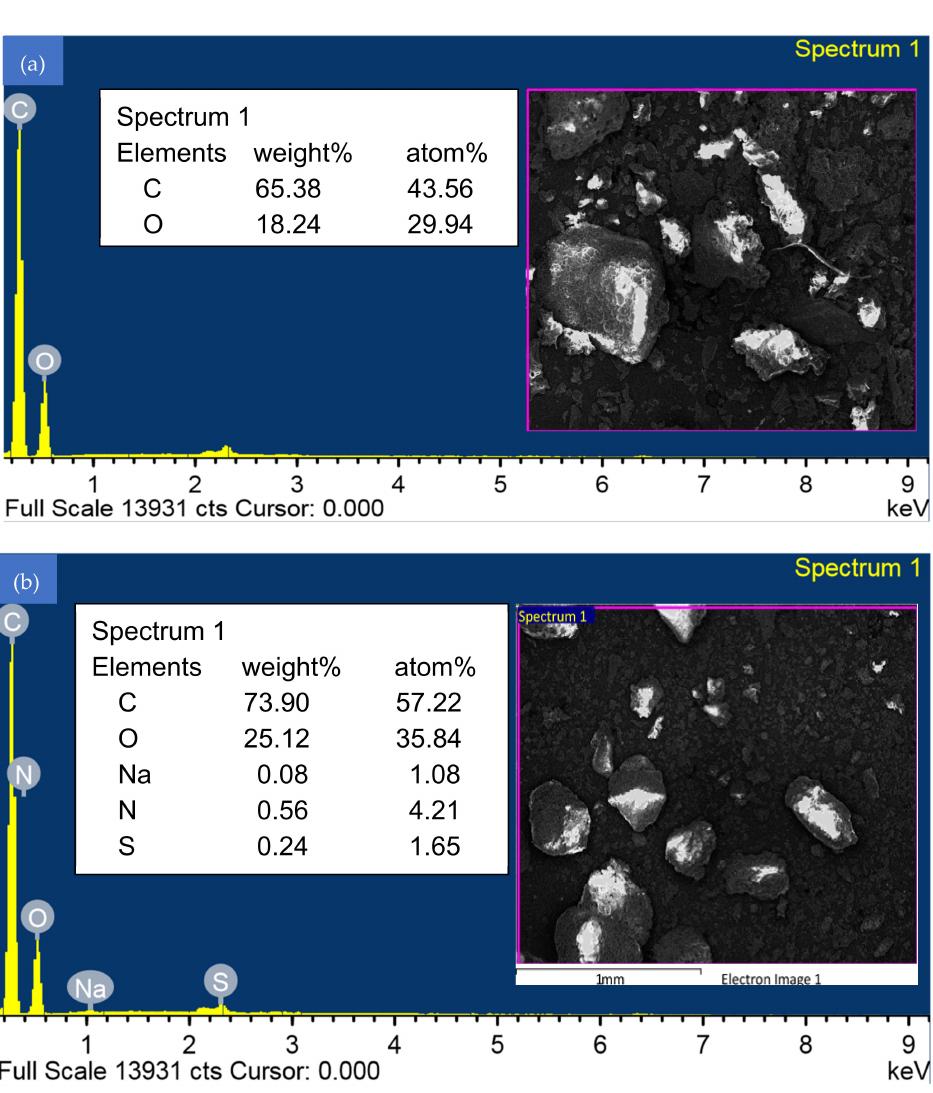
Figure 4. Energy Dispersive X-ray Spectroscopy (EDS) analysis of WSBAC adsorbent ( a ) before RBBR dye adsorption, and ( b ) after RBBR dye adsorption.